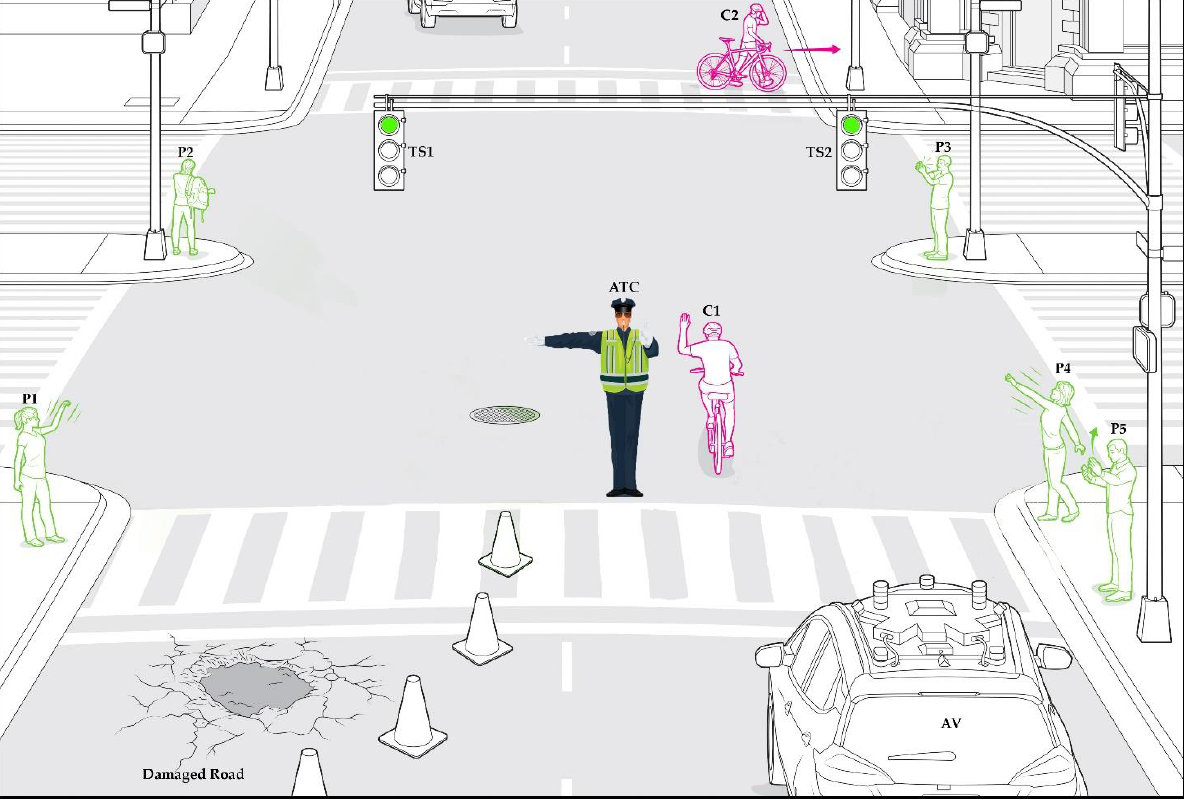
Figure 2. Illustration of an irregular situation with a few commonly occurring scenarios on the road.